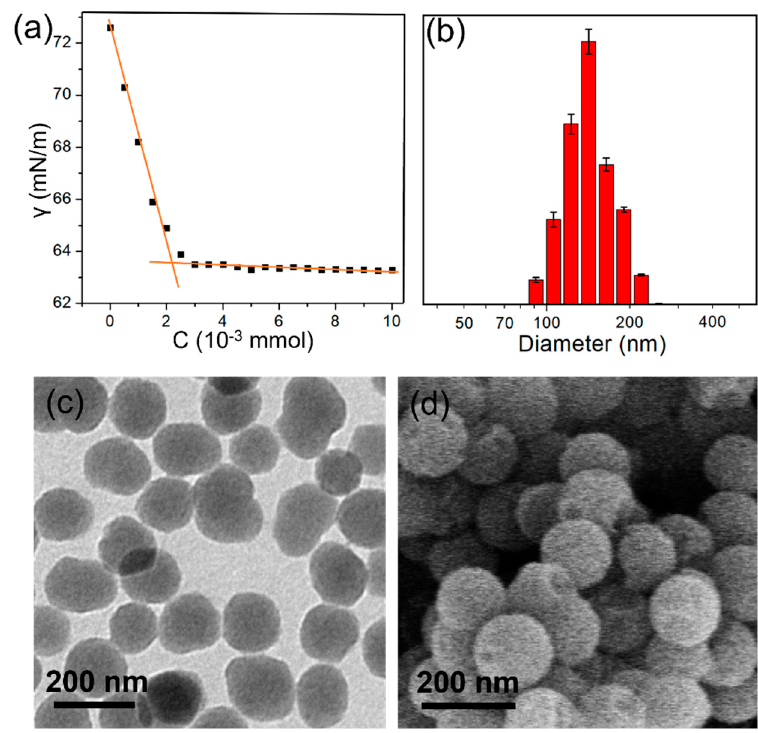
Figure 3. ( a ) Water surface tension as a function of the concentration of TP5/Zn/PM . ( b ) DLS of TP5/Zn/PM self-assembly in water. [C] = 2.50 × 10 − 6 M. ( c ) TEM and ( d ) SEM images of TP5/Zn/PM self-assembly in water [C] = 2.50 × 10 − 6 M.